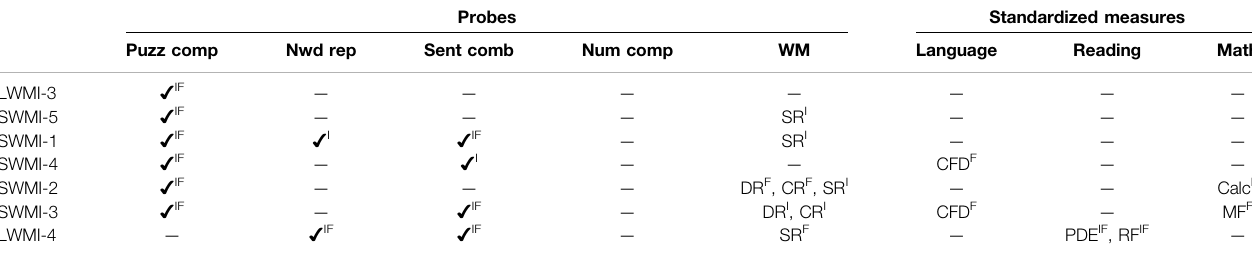
TABLE 2 | Summary of results from probes and standardized measures of working memory, language, reading, and math.